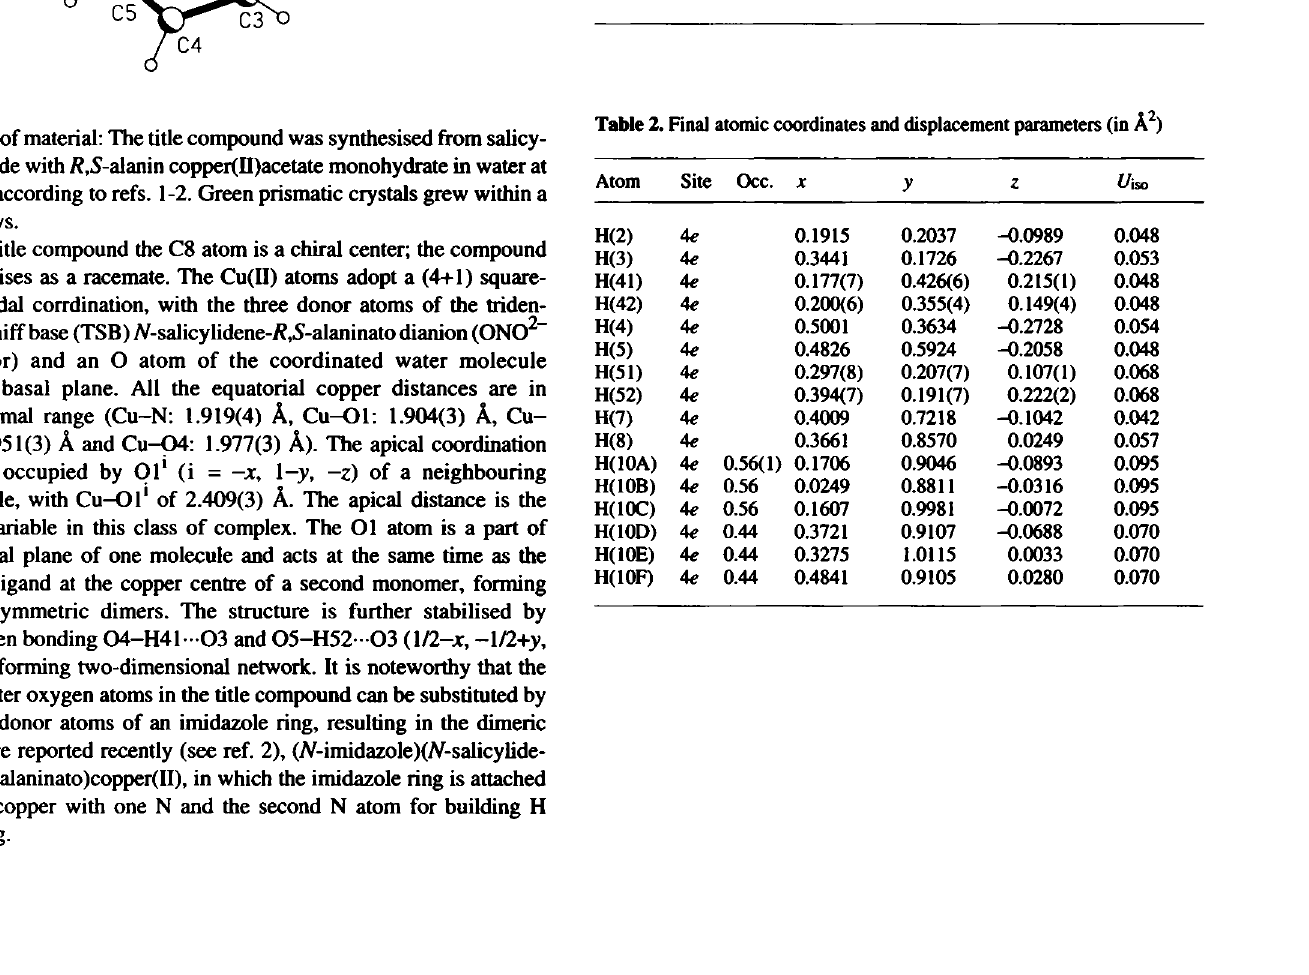
Table 1. Parameters used for the X-ray data collection Crystal: